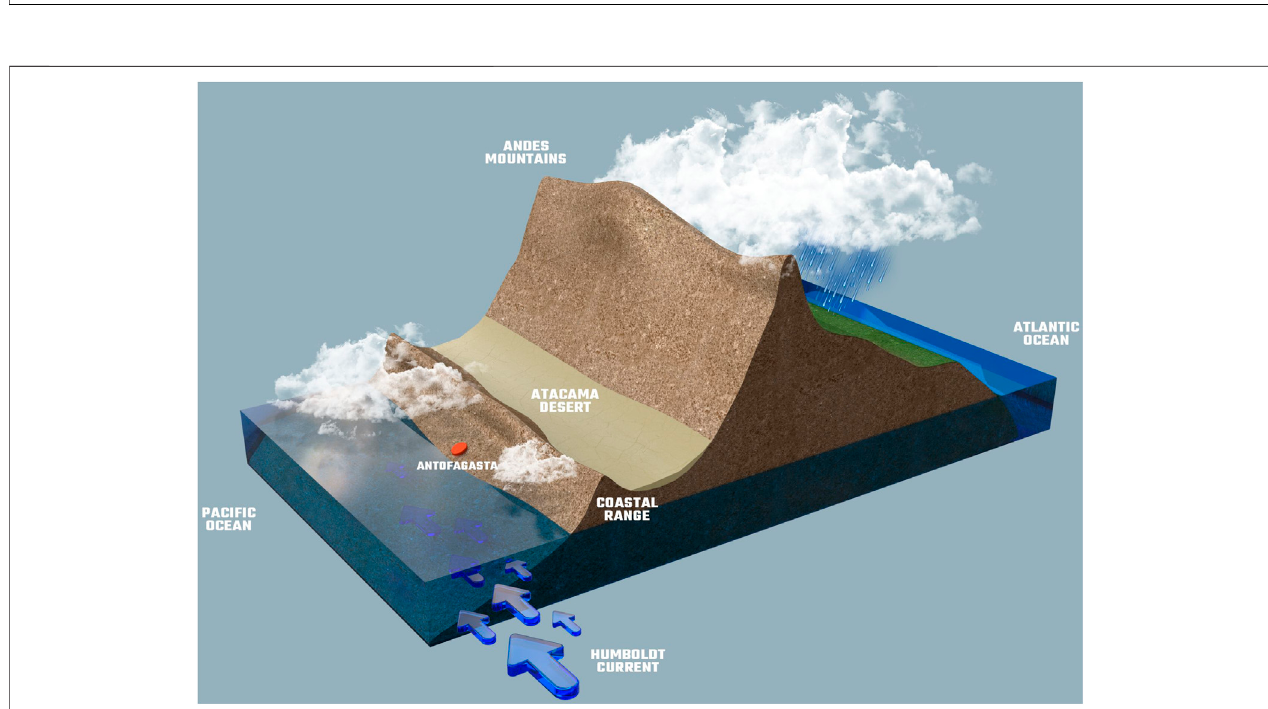
FIGURE 2 | Climatic and geographic factors that explain the extreme aridity of the Atacama.